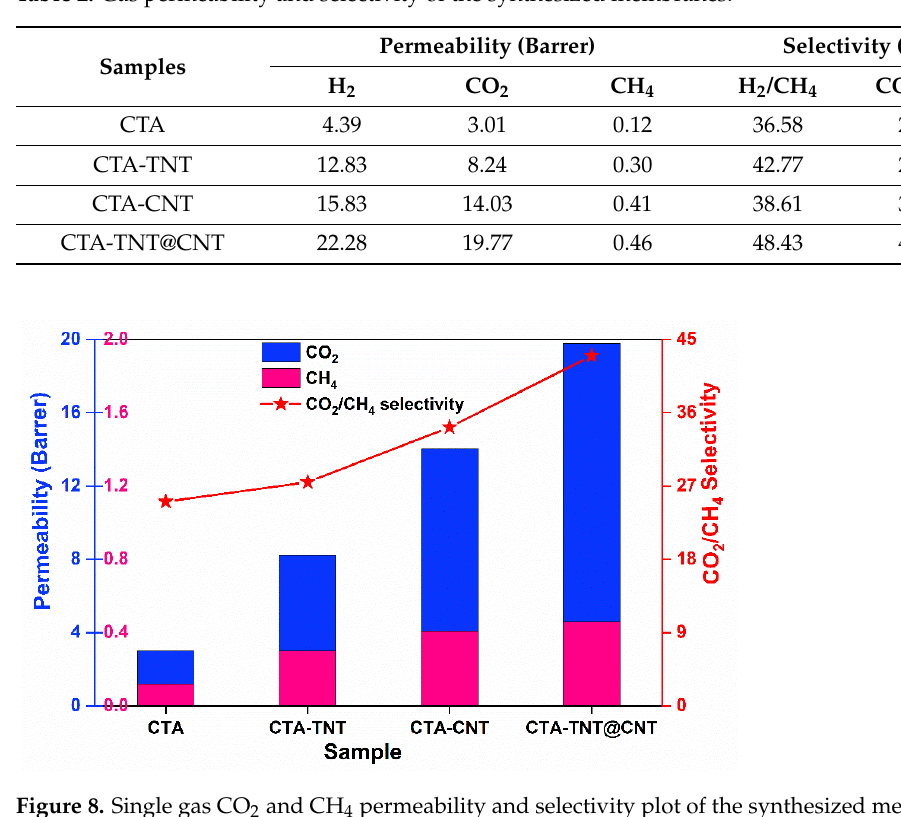
Table 2. Gas permeability and selectivity of the synthesized membranes.